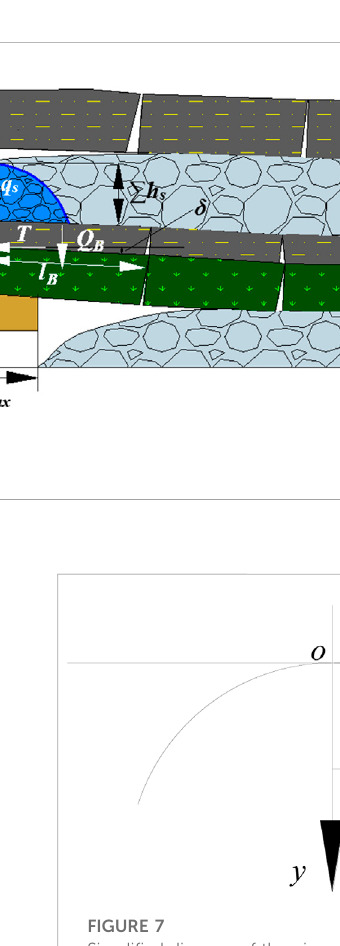
FIGURE 7 Simpli fi ed diagram of the given load of the loose